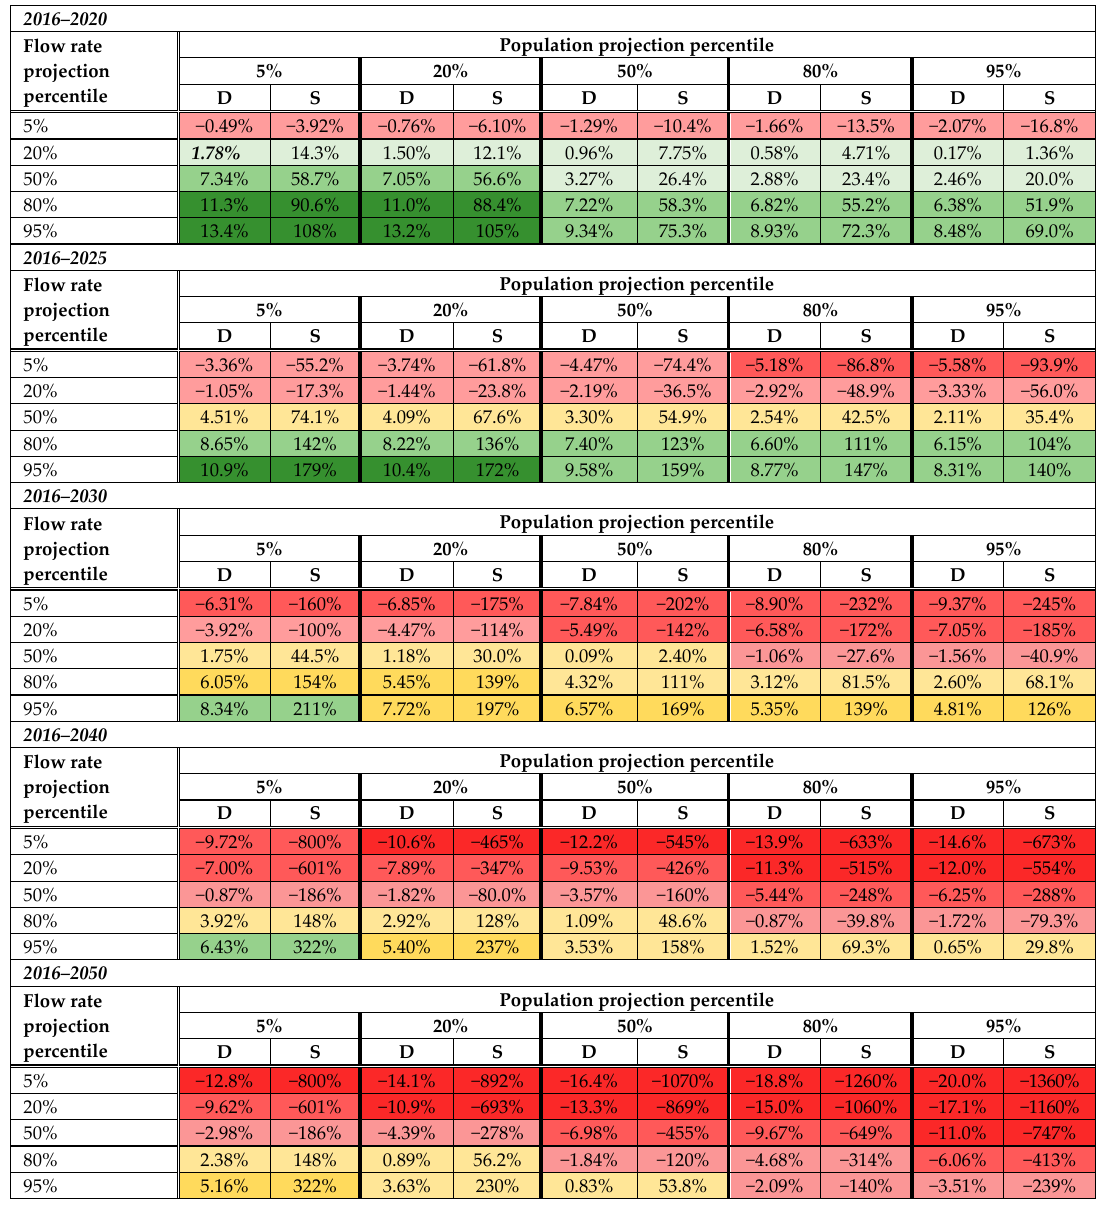
Figure 6. Total extra water available as a percentage of total demand (D) and storage capacity (S)